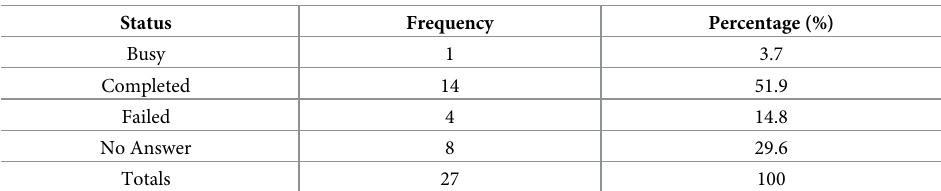
Table 3. Voice messages sent to participants.